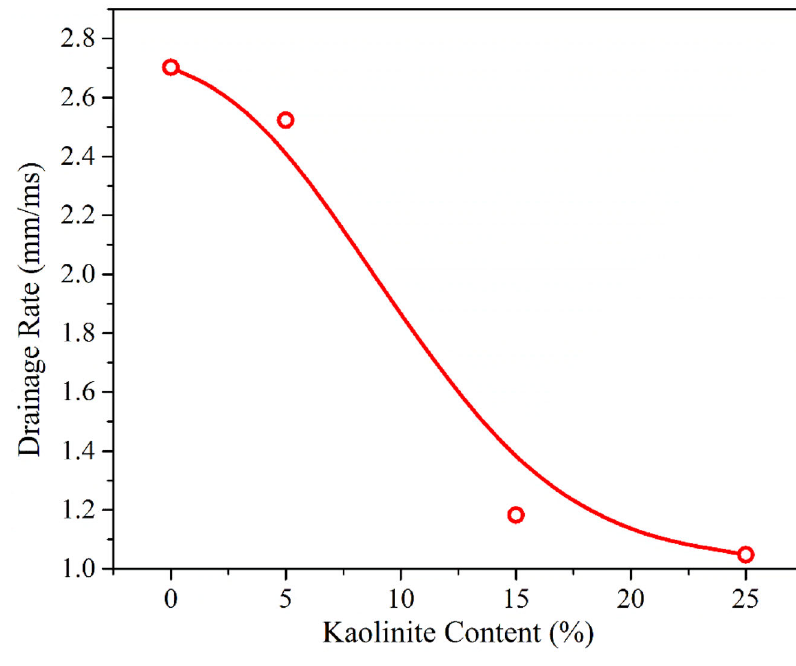
Fig. 9 Curve of coal particle–bubble liquid film drainage rate in suspension with different kaolinite contents